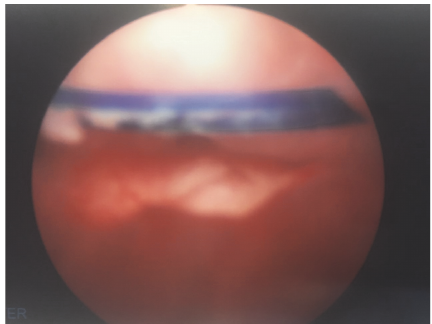
Figure 1: Cystoscopic image of an eroded suture at the level of the proximal urethra near the bladder neck.